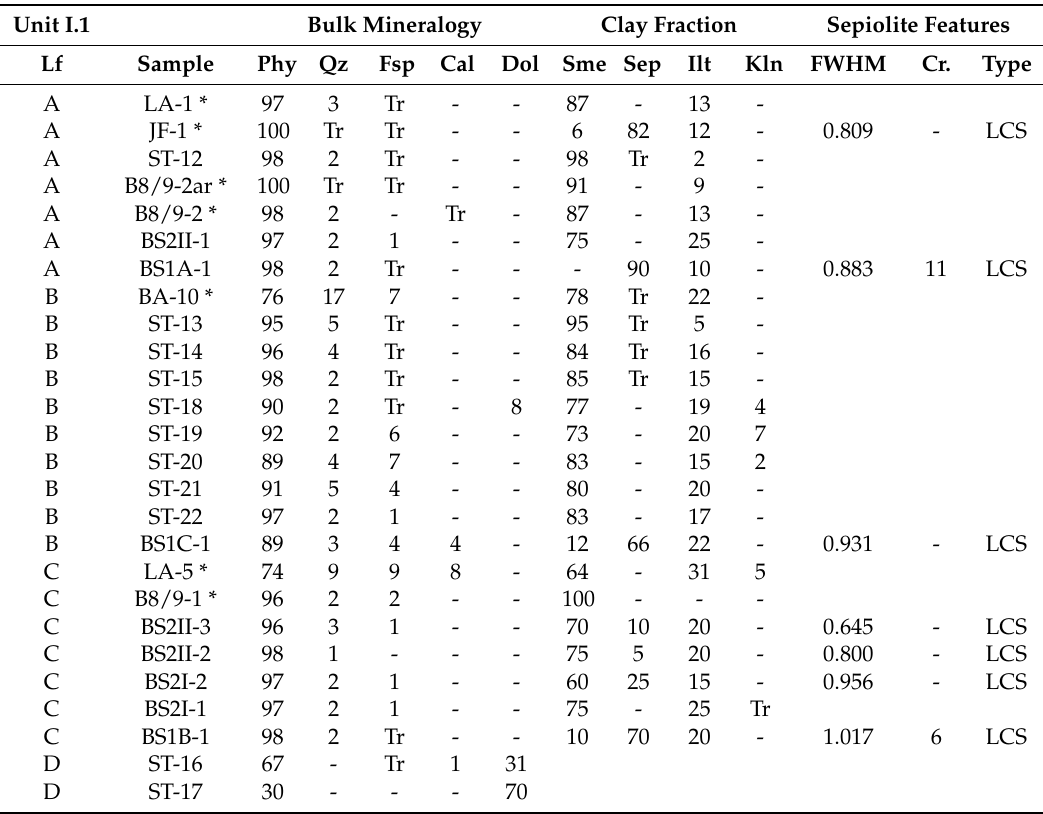
Table 1. Bulk (% w / w ) and clay mineralogy (% w / w ) of Unit I.1 lithofacies. Sepiolite FWHM values ( ◦ 2 Θ ), crystallite sizes (Cr.) (nm) and “crystallinity” are also shown. Abbreviations are according to Whitney and Evans [27], except phyllosilicates (Phy), trace minerals (Tr) and not detected (-): Qz, quartz; Fsp, feldspar; Cal, calcite; Dol, dolomite; Sme, smectite; Sep, sepiolite; Ilt, illite; Kln, kaolinite. The order inside each lithofacies group of samples is related with the geographical location, from north to south, of lithological